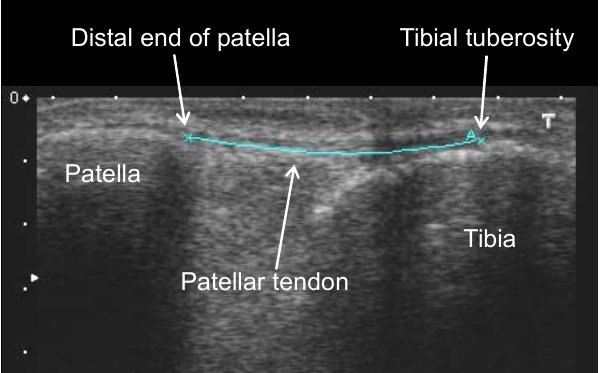
Fig. 2 Typical ultrasound image of the patellar tendon at complete relaxation.